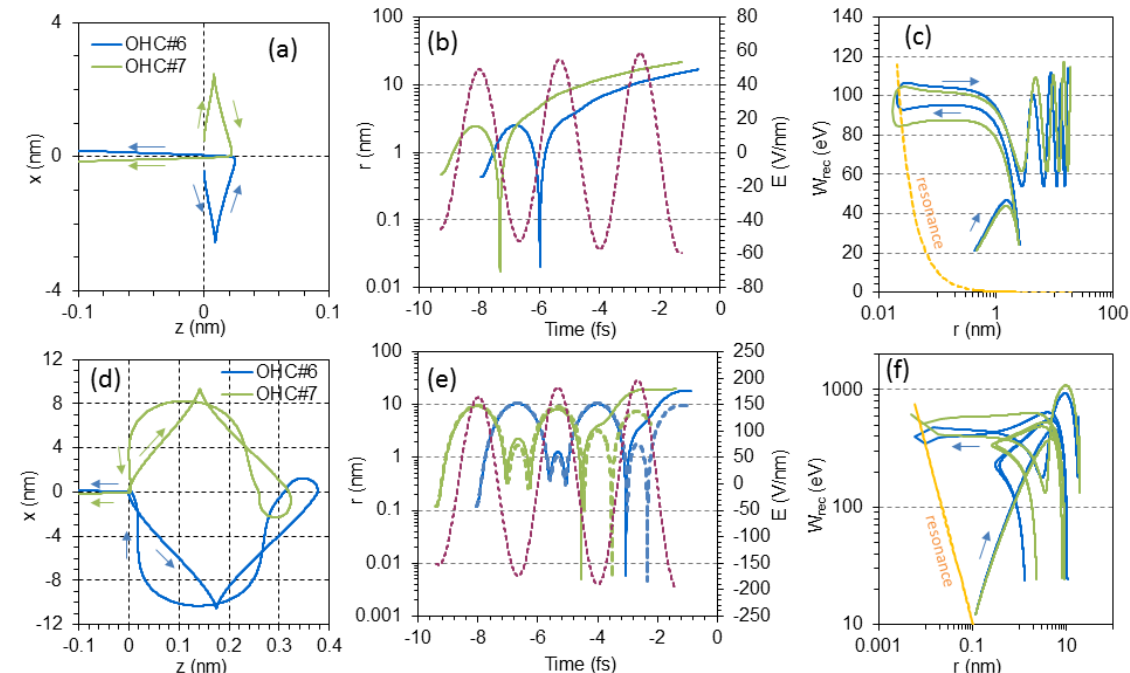
Figure 8. The electron trajectory calculation shows different features ( a – c ) at moderate 5 × 10 14 W/cm² and ( d – f ) at high 5 × 10 15 W/cm² laser intensities in helium ionized by a 30 fs-long laser pulse. The laser is polarized along the x-direction and propagates along the z-axis. ( a , d ) The electron is ionized six or seven optical half-cycles (OHCs) before